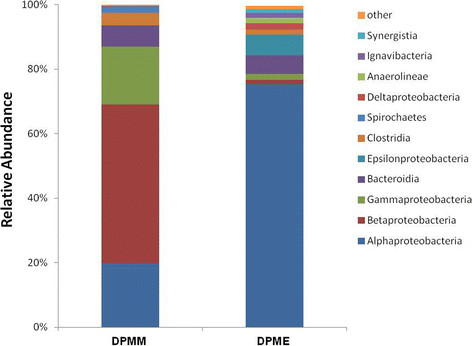
Relative abundances of bacterial phyla and proteobacterial classes in DPMM and DPME.